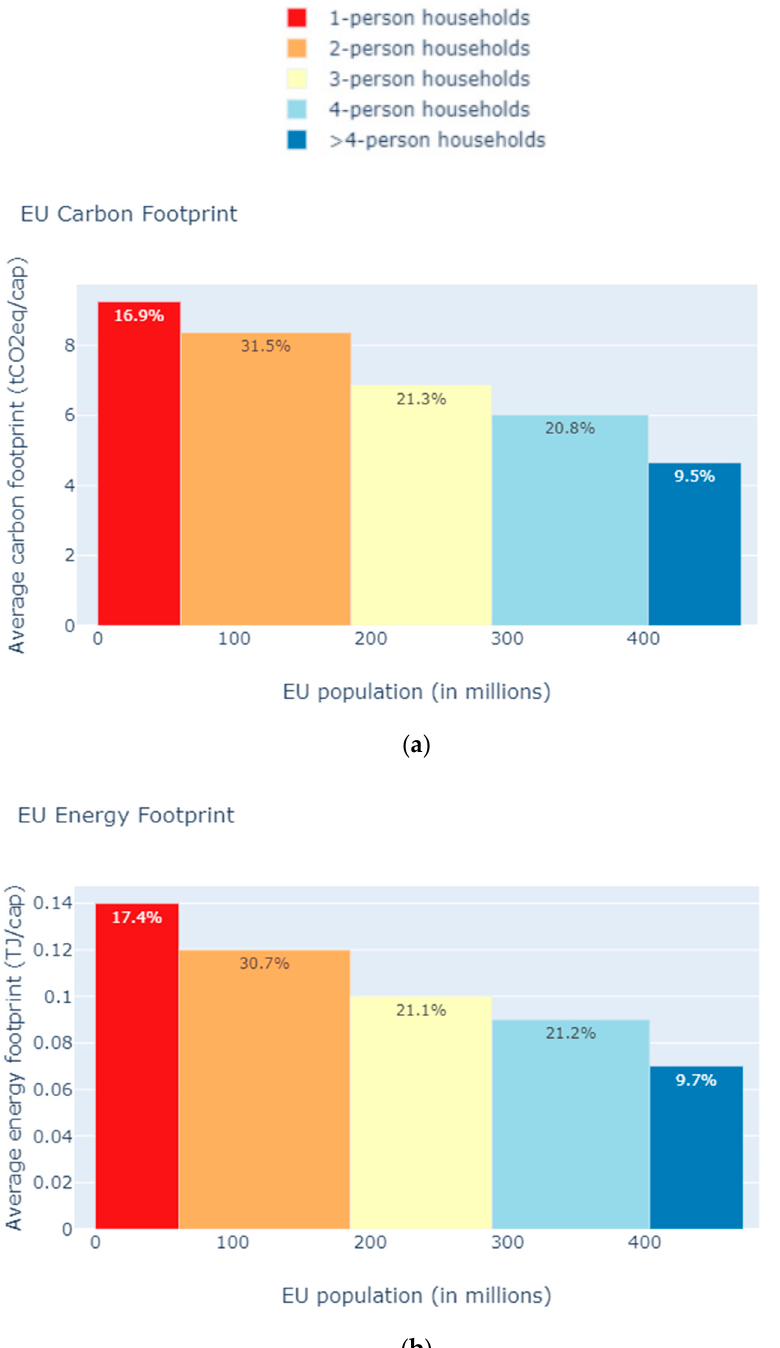
Figure 1. Distribution of EU carbon ( a ) and energy ( b ) footprint shares by household size. The total carbon and energy contribution can be split into two parts: the average carbon and energy footprints per capita (y-axis) and the number of people within the household cohort in the EU (x-axis). The %-s represent the share of total EU carbon and energy footprints by household sizes. Source: own calculations based on country population from the World Bank for 2010.